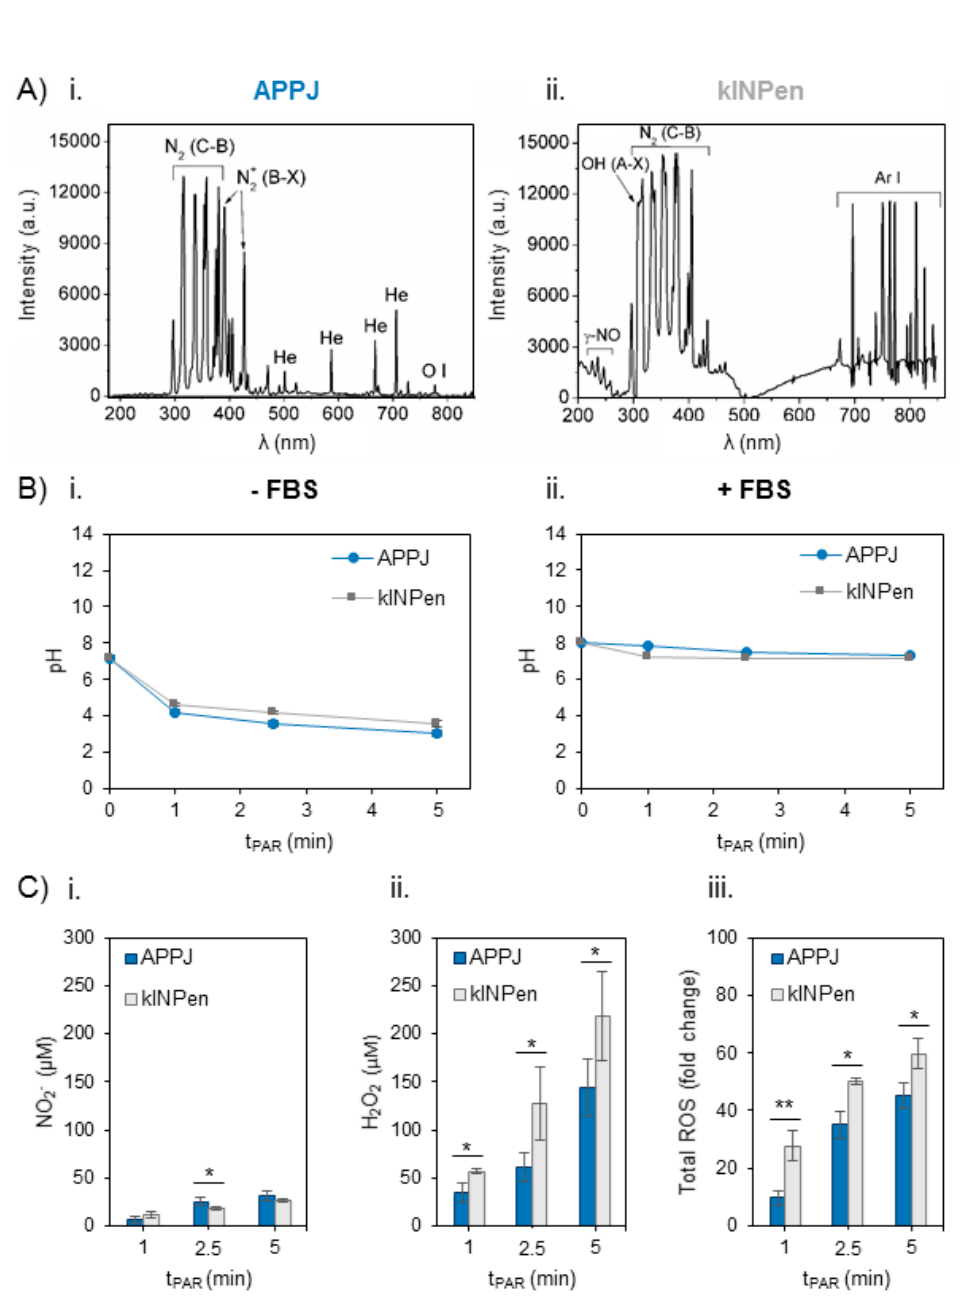
Figure 1. Reactive oxygen and nitrogen species in the plasma gas phase and time-dependent concentration generated in Ringer’s saline at 1 L / min of gas flow, 10 mm of distance between the nozzle of the plasma jet and the surface of the liquid (2 mL in 24 well-plates). ( A ) Optical Emission Spectra (OES) of the plasma gas phase in ( Ai ) atmospheric pressure plasma jet (APPJ) and ( Aii ) kINPen during treatment of Ringer’s saline. ( B ) pH evolution in Ringer’s saline treated by APPJ and kINPen at increasing treatment time ( Bi ) without and ( Bii ) with addition of 10% FBS after treatment. ( C ) Concentration of ( Ci ) NO 2 − , ( Cii ) H 2 O 2 and ( Ciii ) total reactive oxygen species (ROS) measured in situ and relativized to untreated plasma-activated Ringer’s saline (PAR). Reactive oxygen and nitrogen species (RONS) created by both plasmas in 2 mL of Ringer’s saline were measured right after plasma treatment and addition of 10% of FBS. Asterisks represent statistically significance di ff erences between APPJ and kINPen for each time-point ( n = 3; * p -value < 0.05; ** p -value < 0.01; two-sided Student’s t -test).